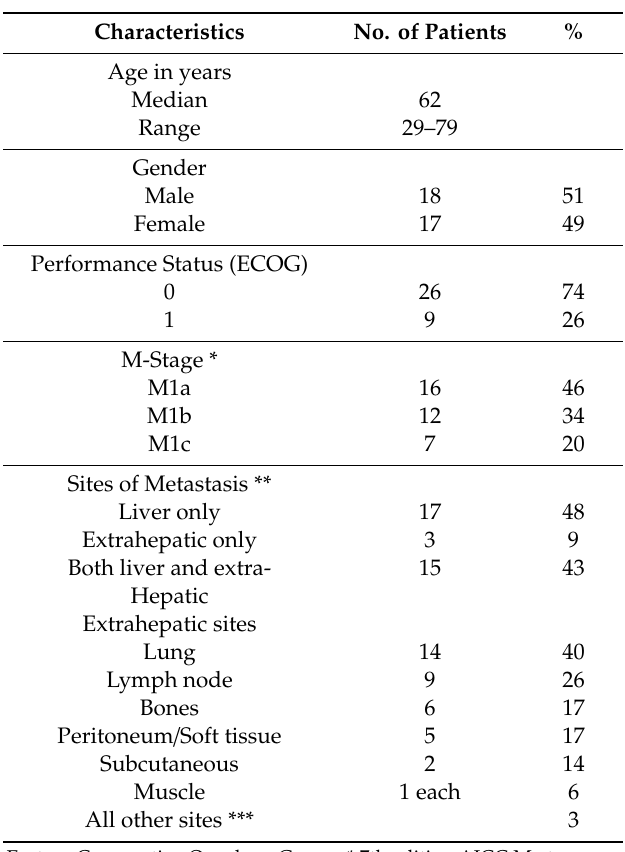
Table 1. Baseline patient